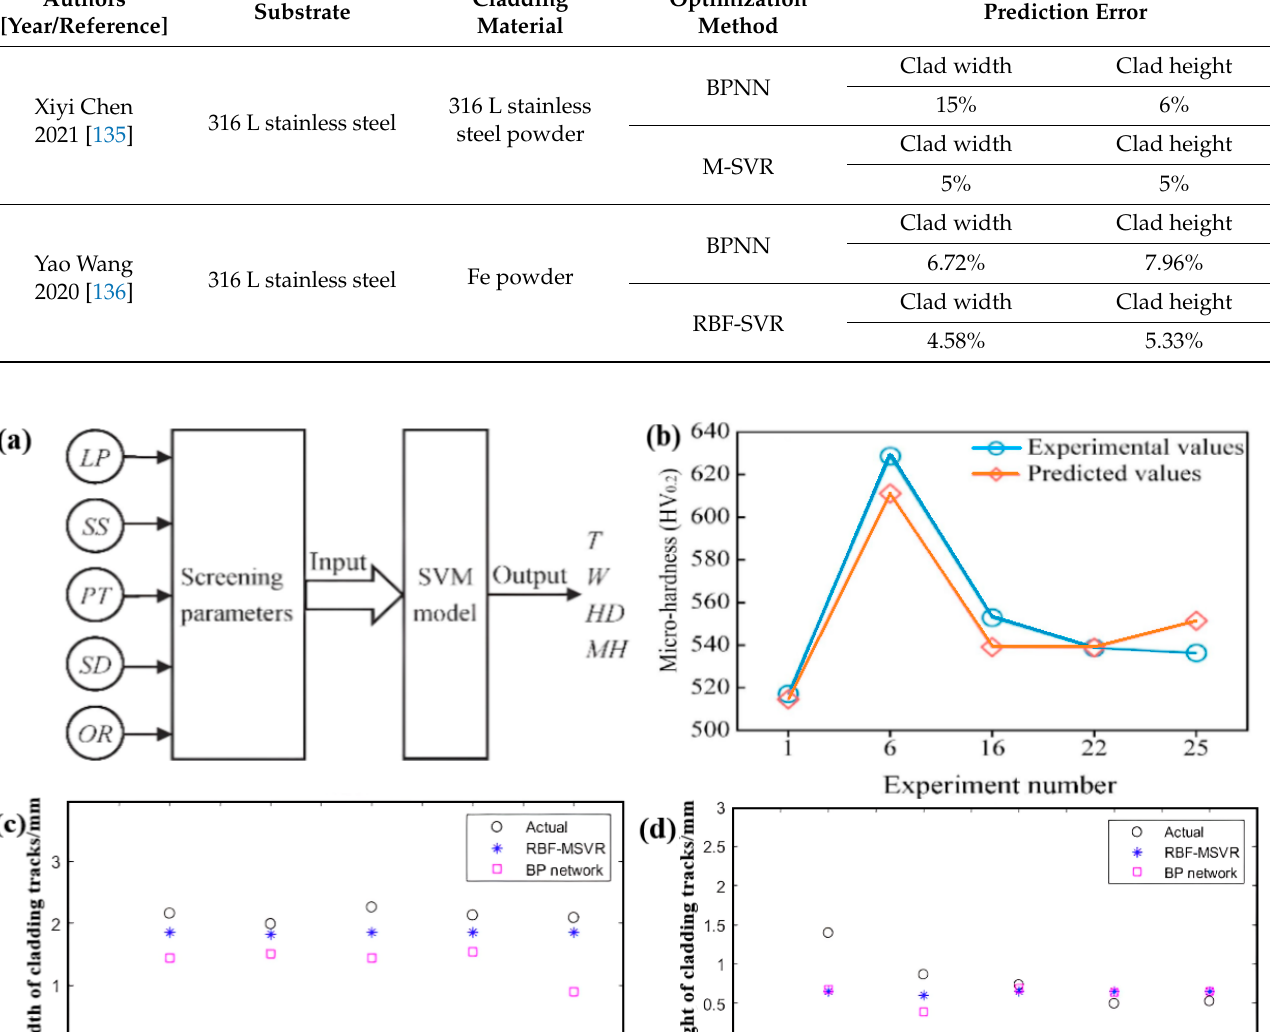
Table 5. Comparison of support vector regression and BP neural network prediction results.